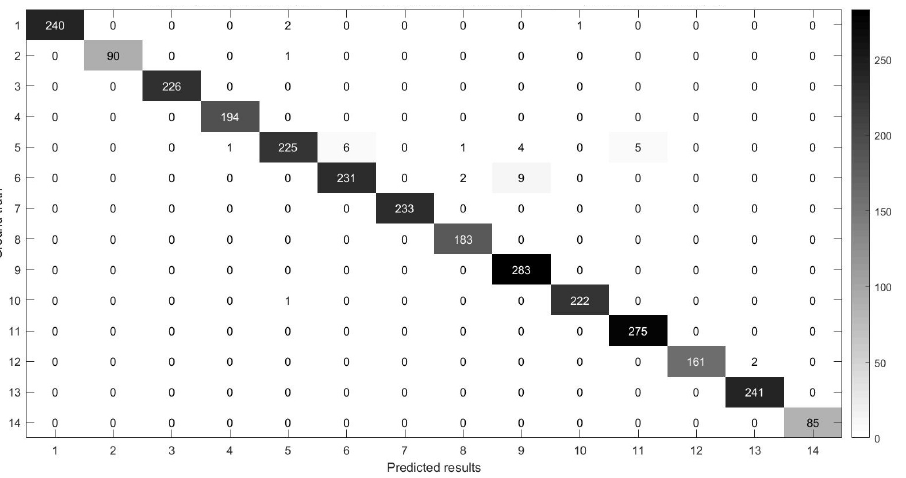
Figure 14. The confusion matrix between the predicted results of MSR-3DCNN and ground truth on the BO dataset using 10% samples for training and ( 9 × 9 ) patch